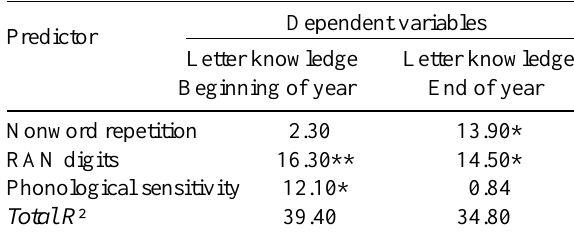
Percentages of Variance in Low-performing Group’s Letter Knowledge at the Beginning and at the End of the